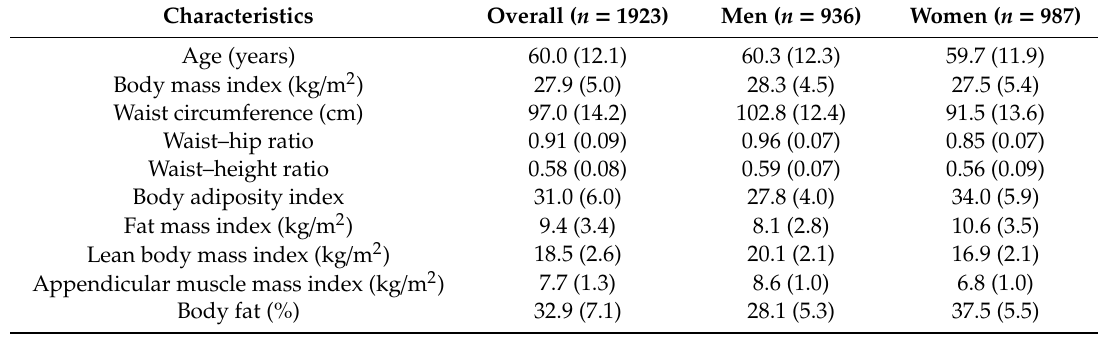
Table 1. Benchmark data on the KORA (Cooperative Health Research in the Region of Augsburg) FF4 study population (mean (standard deviation)).